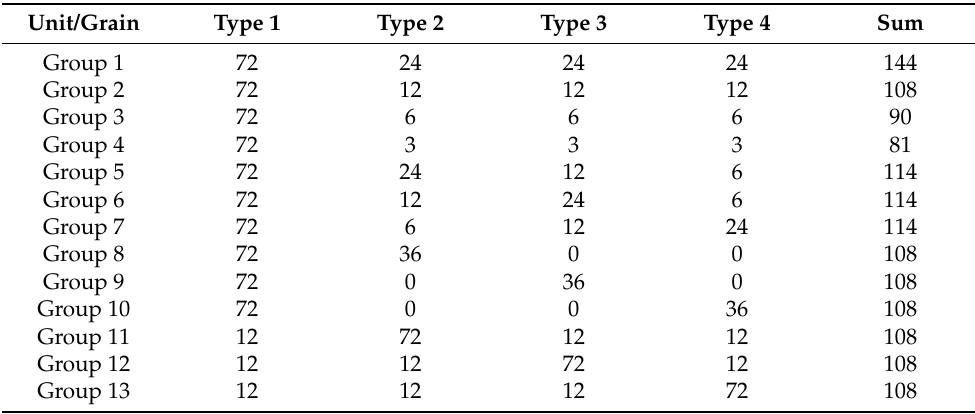
Table 1. Data grouping details to simulate different cases of seed purity